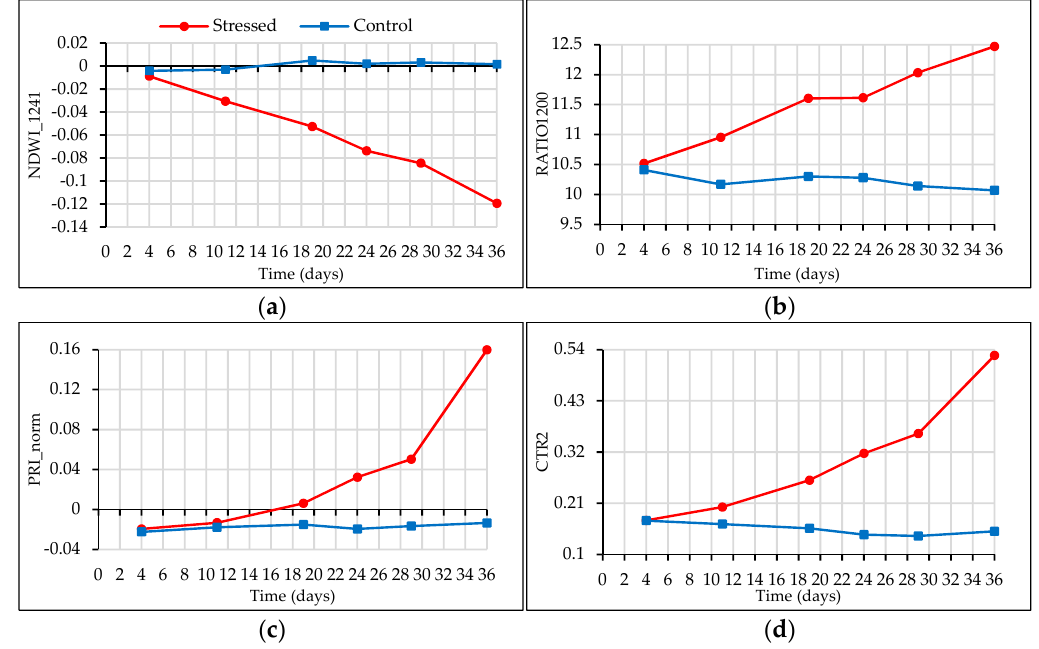
Figure 7. Trend of the best indices during the stress episode. ( a ) NDWI_1241 at day 11; ( b ) RATIO1200 at day 11; ( c ) PRI_norm at day 36; ( d ) CTR2 at day 36. NDWI_1241, the best performing index for short-term stress (at day 11) showed a downward trend over time during the experiment, whereas RATIO1200, PRI_norm and CTR2 showed upward trends. In addition, we found that BGI2 and NDWI_1241 had detectable and strong responses for both short-term and long-term stress.